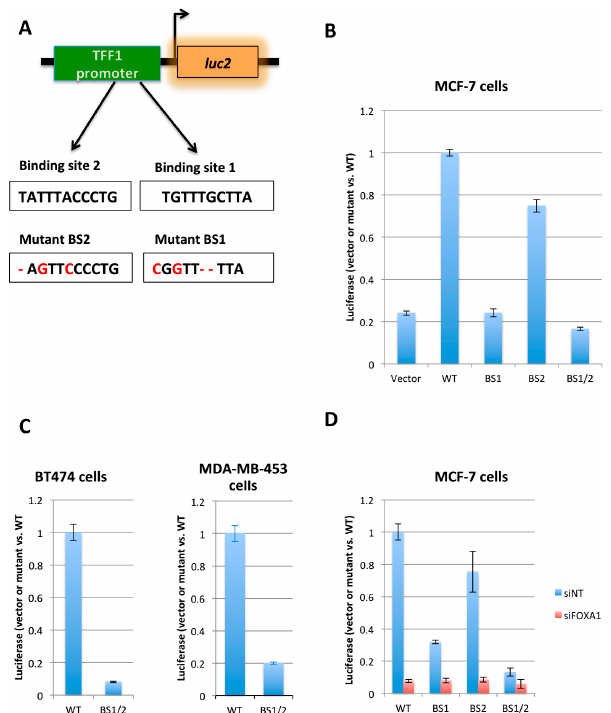
Figure 1. Design of the luciferase reporter and validation. ( A ) Schematic design of the luciferase reporter reflecting FOXA1 activity and the mutations of FOXA1 binding sites. The promoter of Tff1 gene was cloned into the upstream of the luciferase expression cassette of pGL4.20 vector, two FOXA1 motifs are mutated to the sequences in red. ( B ) The wild type reporter (WT), reporter with the mutation in BS1 (BS1), BS2 (BS2), and double mutant (BS1/2) were transfected into MCF-7 cells for validation. Luciferase assay was performed to measure the reporter activity ( n = 3). ( C ) Wild type and double mutant reporter plasmids were validated further with BT474 ( left ) and MDA-MB-453 ( right ) cell lines ( n = 3). ( D ) The pGL4.20-WT, BS1, BS2, and BS1/2 were transfected into MCF-7 together with non-targeting siRNA (siNT) and siRNA targeting FOXA1 (siFOXA1). Luciferase assay was performed 48 h after transfection ( n = 3).